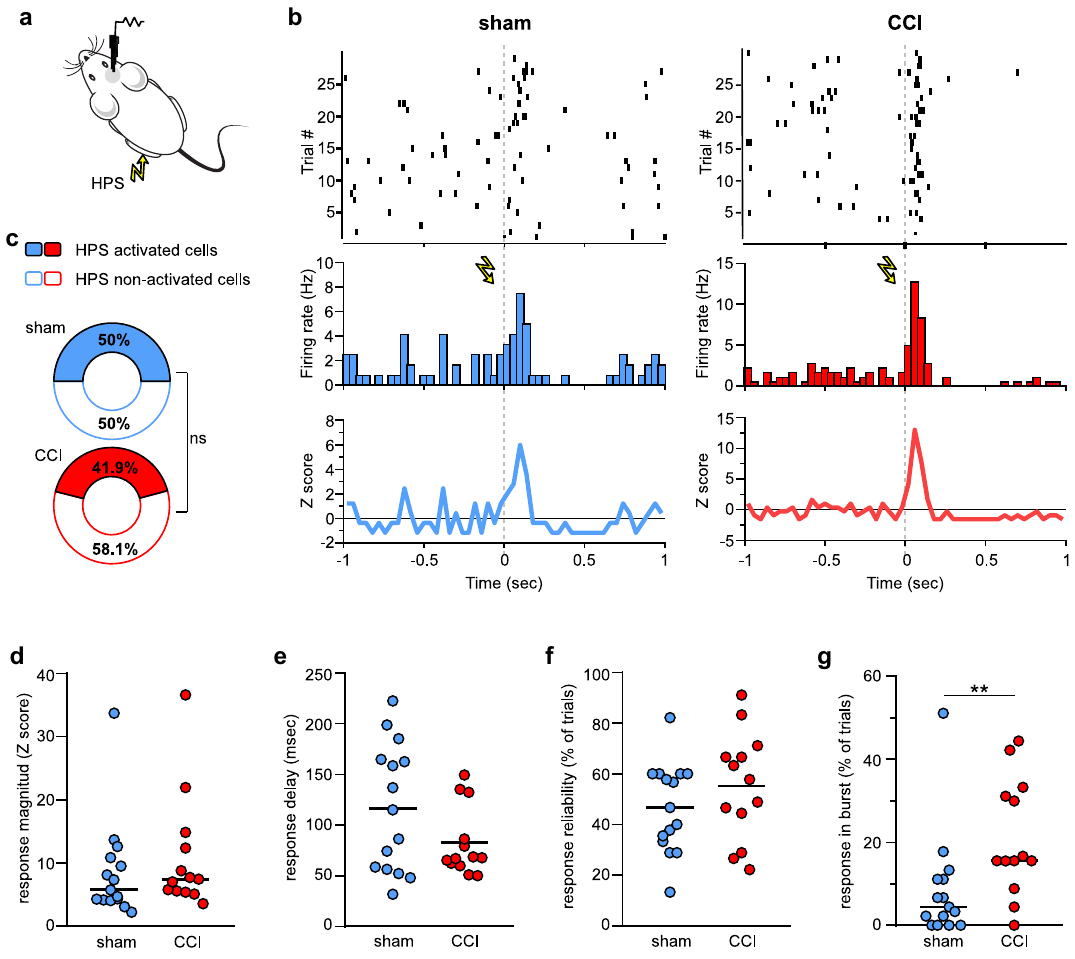
Figure 4. vACC neurons are activated by noxious stimuli. (a) Schematic diagram representing the electrophysiological recording of vACC while applying an electrical stimulus (HPS) to the operated hind paw. (b) Top: dot-raster representing firing activity before and after stimulus onset of two neurons activated by HPS. Each line correspond to a single trial aligned at the time of stimulus presentation (vertical dotted line). Middle and bottom: peri-stimulus firing histogram and Z score graph corresponding to the traces depicted above. (c) The proportion of HPS activated cells was similar between sham and CCI mice (ns: p > 0.05, Fisher exact test). (d-f) The magnitude, delay and reliability of the response to HPS in HPS-activated neurons were not modified by sciatic nerve lesion. (g) The proportion of trials with burst responses in HPS-activated neurons was higher in injured mice (** p < 0.01, Mann Whitney